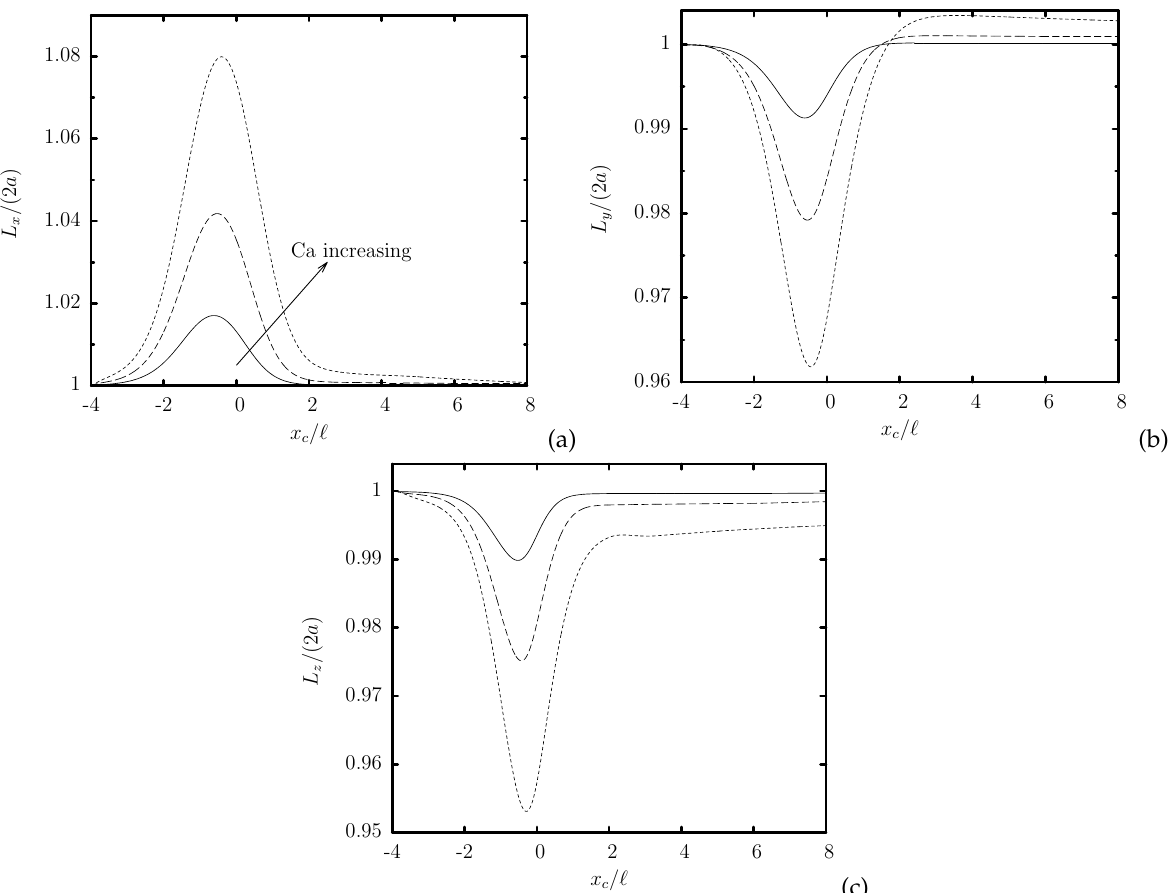
Figure 8. The capsule lengths as a function of the centroid x c , for a Skalak capsule with a / (cid:96) = 0.8, C = 1, λ = 1, z 0 c / (cid:96) = 0.5 and capillary numbers Ca = 0.02,0.05,0.1. ( a ) Length L x , ( b ) width L y and ( c ) height L z